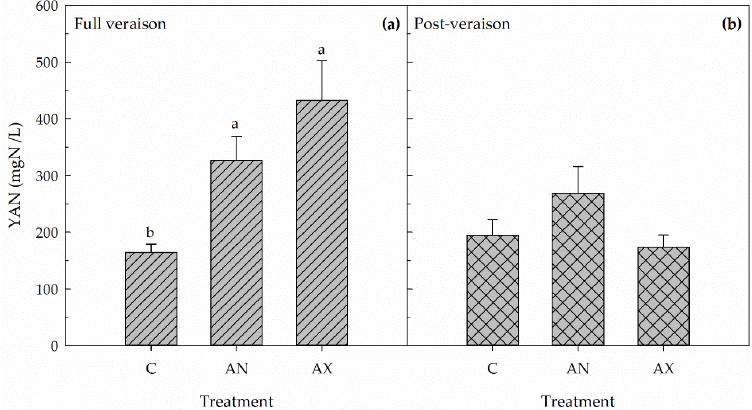
Figure 4 . Yeast assimilable nitrogen (YAN) concentration in berries measured at harvest in 2017 in control untreated plants (C) and in vines sprayed at full veraison ( a ) or post-veraison ( b ) with Aminoprotein (AN) or Aminomax (AX). Within each panel, means (n = 8) followed by different letters are significantly different according to Duncan’s test ( p ≤ 0.05).